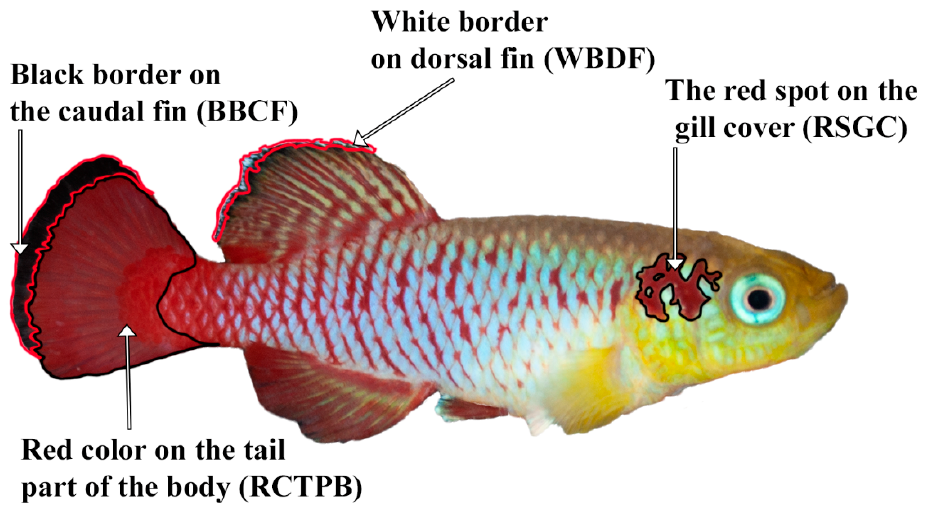
Figure 2. First set of body zones used in the measurement of N. guentheri .